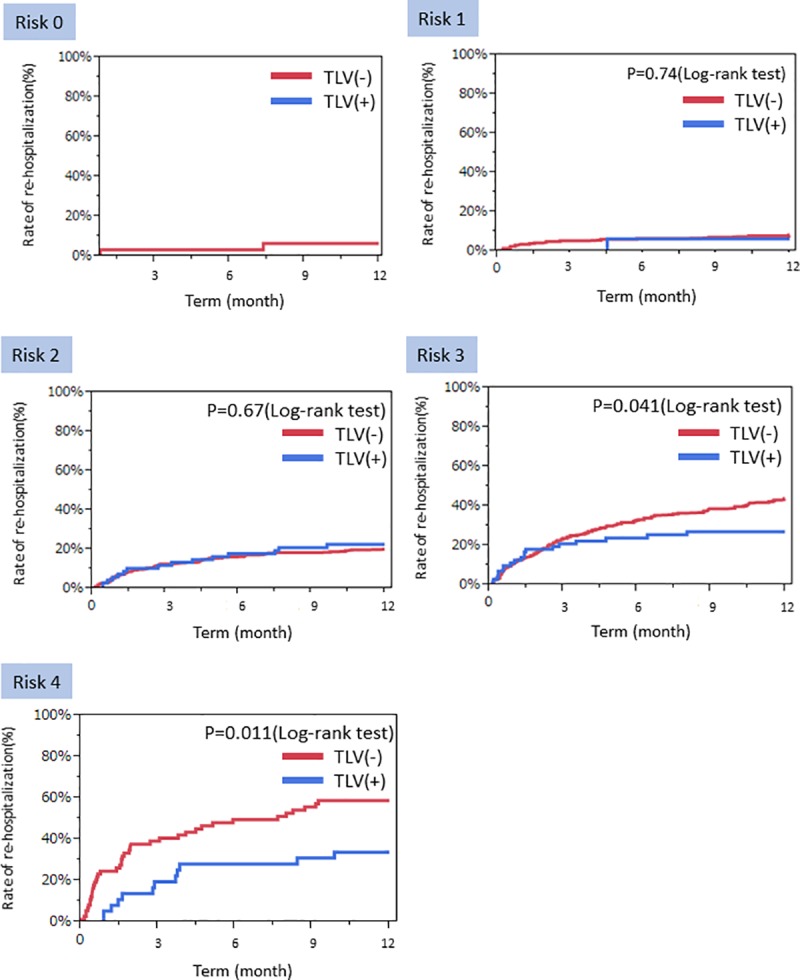
Cumulative incidence curves of re-hospitalizations risk.Cumulative incidence curves of re-hospitalizations risk for worsening of heart failure after 1-year follow-up in the validation subset based on their risk score. Comparison of TLV versus no TLV.